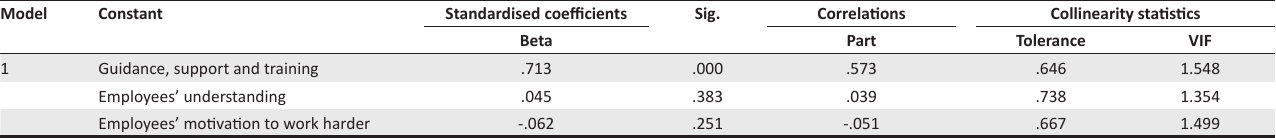
TABLE 7: Linear regression analysis for variables that predict cooperative objective setting. Model Constant Standardised coefficients Sig.